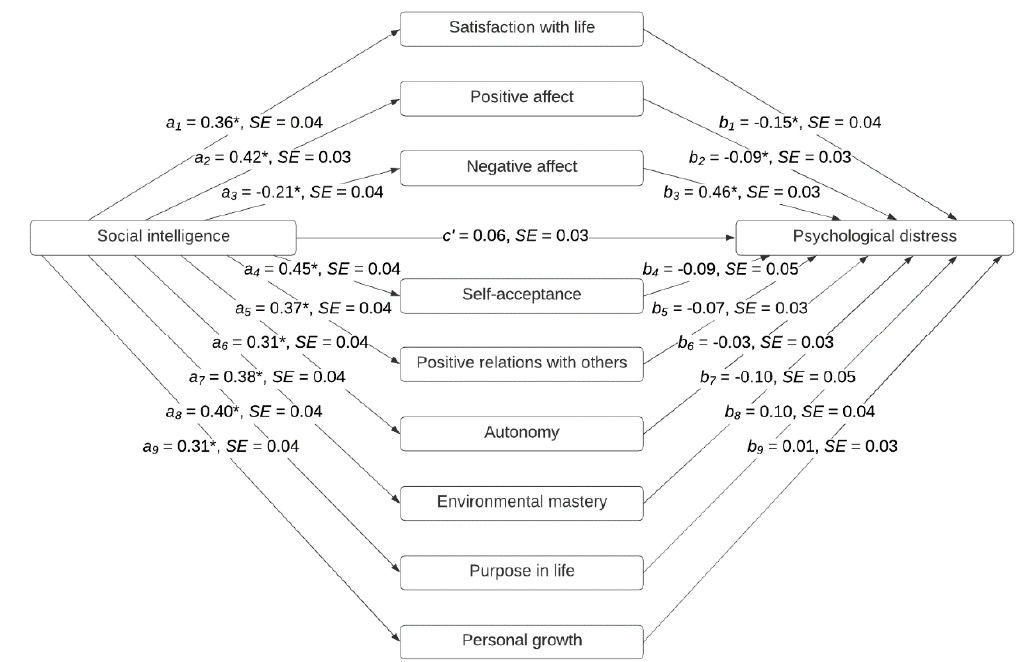
Figure A1. Parallel multiple mediator model of social intelligence, subjective well-being, psychological well-being, and psychological distress for women. Standardized coefficients and standard errors ( SE ) are shown in the figure. * p < 0.001.